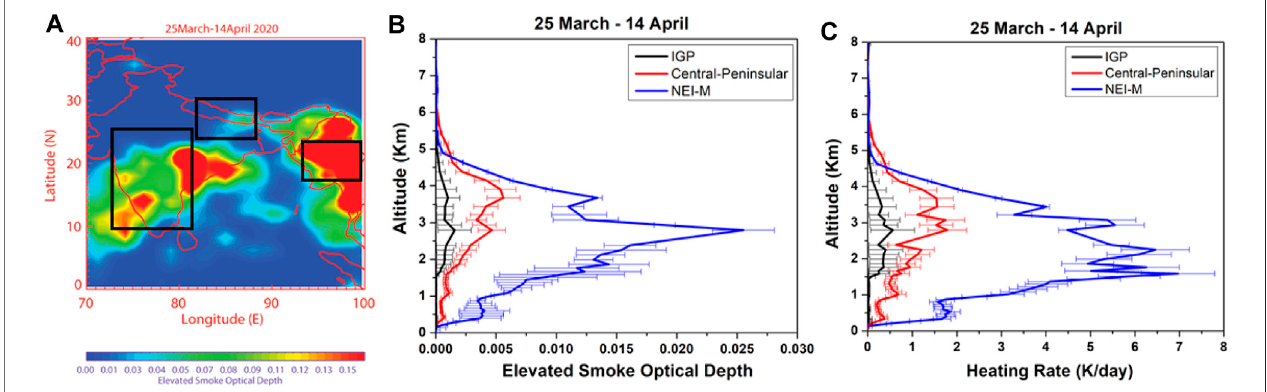
FIGURE 4 | (A) Spatial distribution of elevated smoke optical depth from CALIPSO, (B) pro fi les of elevated smoke optical depth averaged over the central peninsular, Northeast-India-Myanmar region, and IGP, (C) same as (B) but for heating rate (K/day). The horizontal lines in Panels (B,C) indicate standard